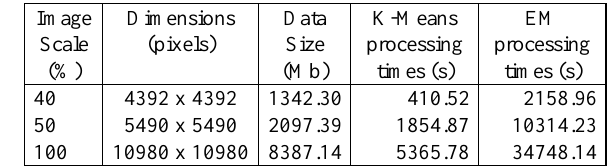
Table 2. Processing times for K-Means and EM